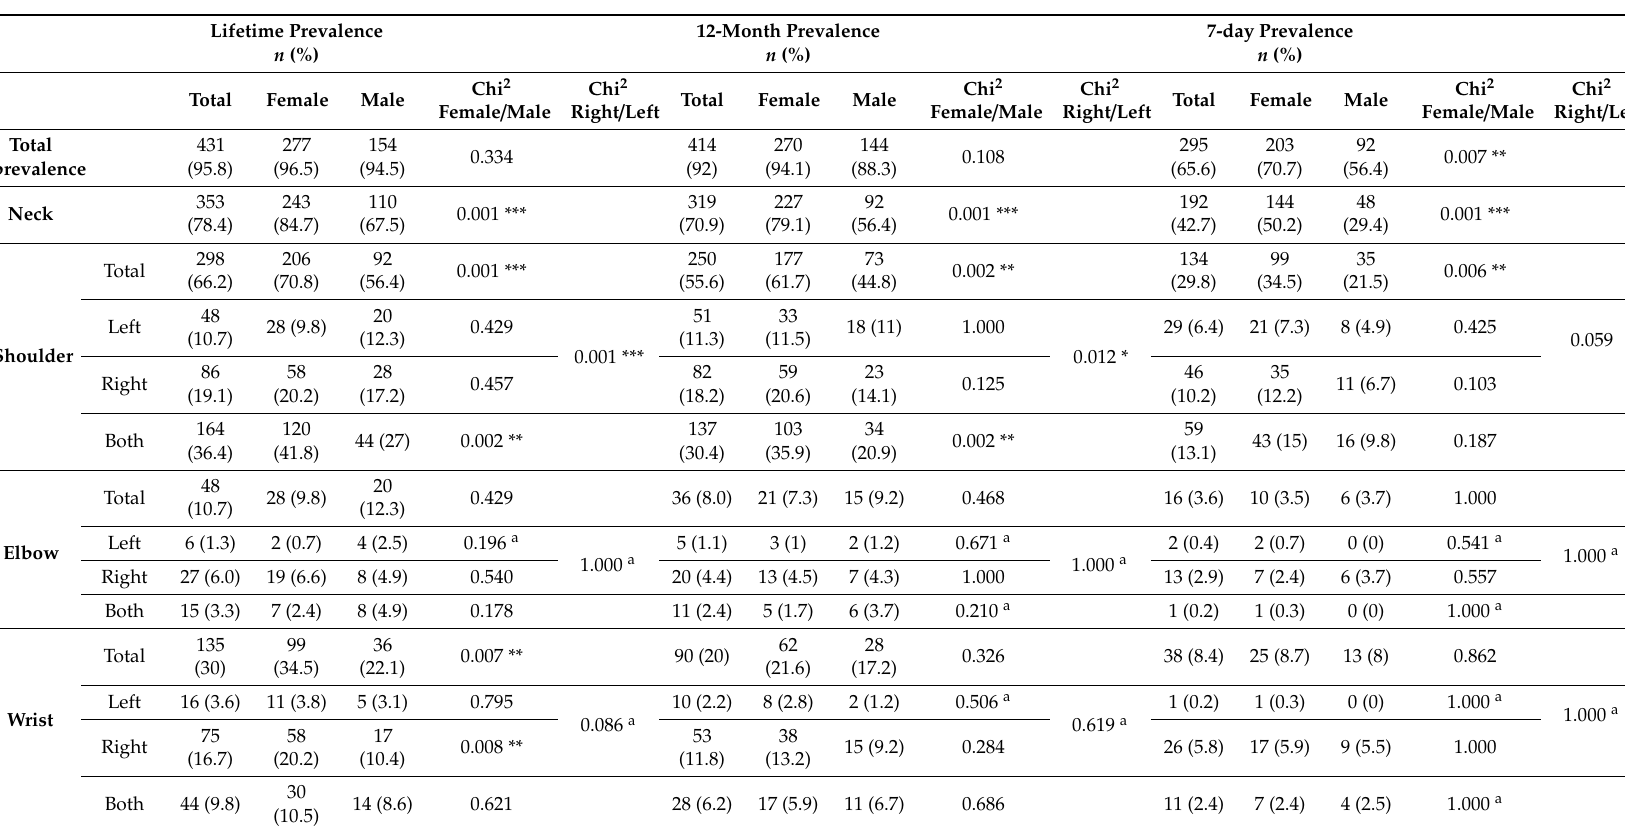
Table 4. Lifetime, 12-month and 7-day prevalence in terms of body regions for all respondents, separated by gender. An asterisk after the chi 2 value symbolizes the significance level (* p < 0.05, ** p < 0.01, *** p < 0.001). An ‘ a ’ stands behind the chi 2 test, if Fisher’s exact test was applied when 20% of the cells of a contingency table were below